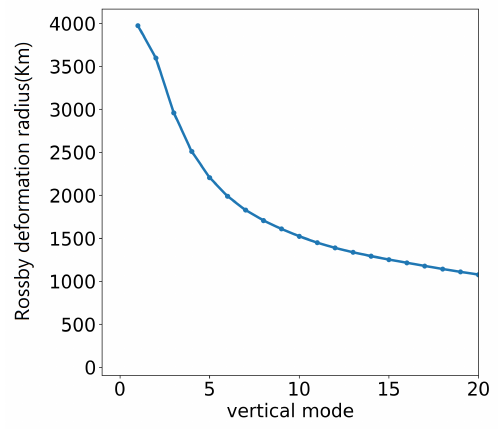
(cid:112) c m / β (in Km) as a function of the vertical mode